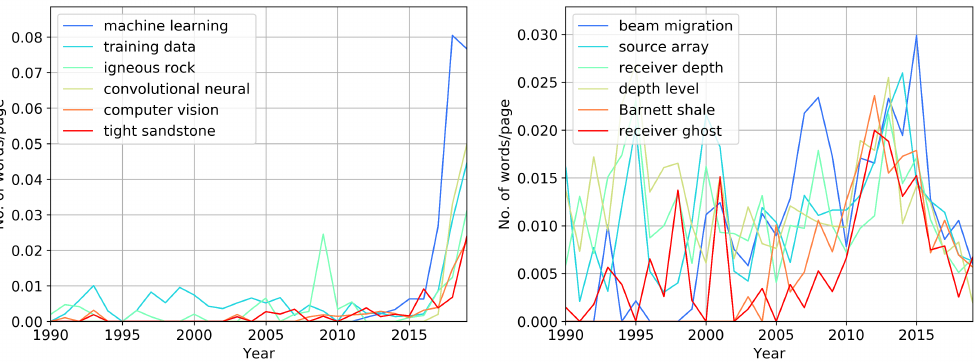
Figure 12. Bigrams that show the highest rate of growth in occurrence ( left ) and decline ( right ) in the past four